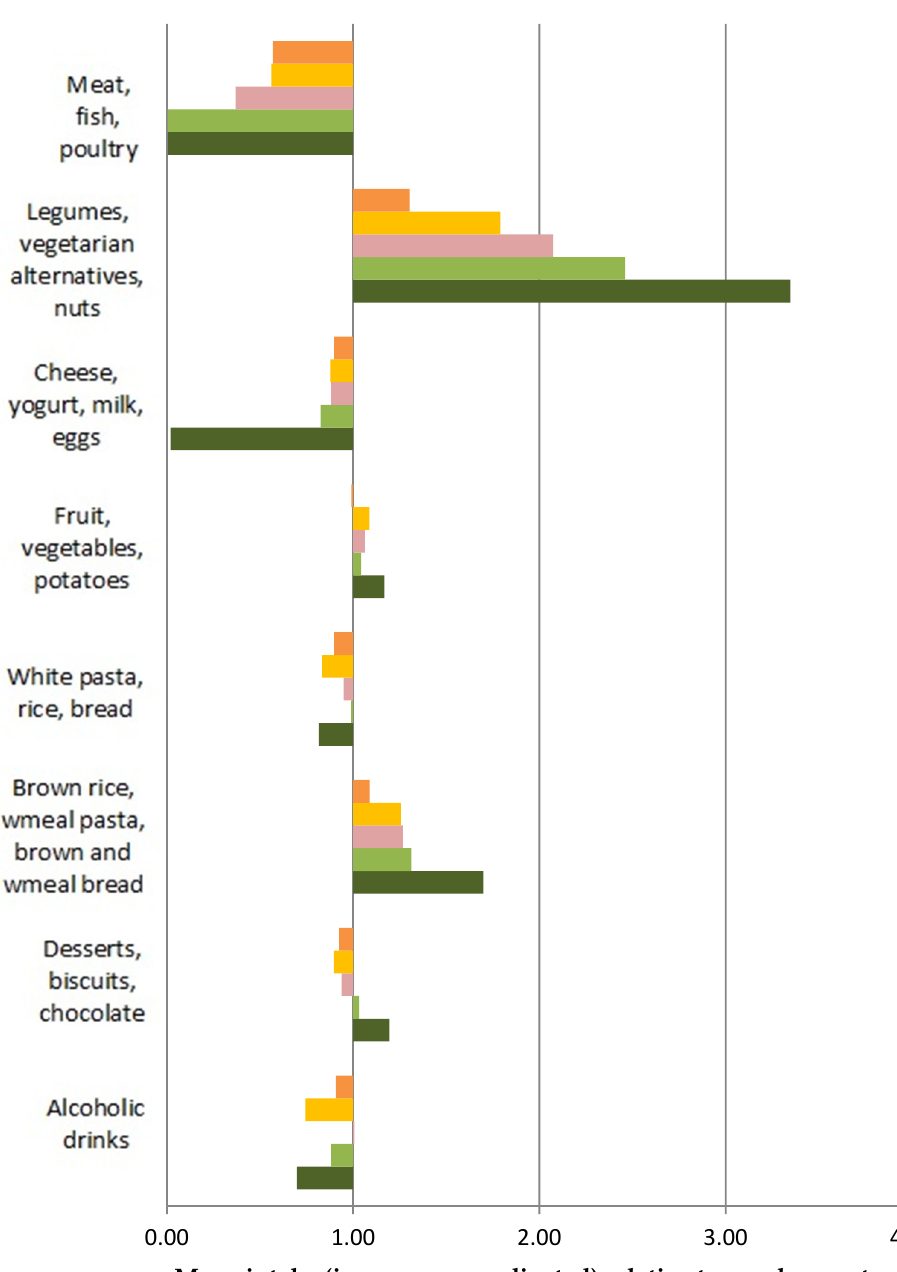
Figure 2. Relative age-adjusted mean (g) consumption of foods in low meat-eaters, poultry-eaters fish-eaters, vegetarians and vegans compared to regular meat-eaters among women.